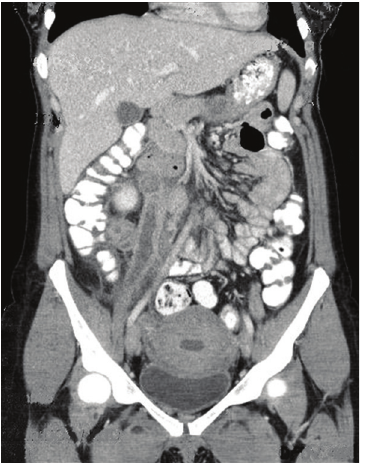
Figure 2: Coronal section right ovarian vein case 1.